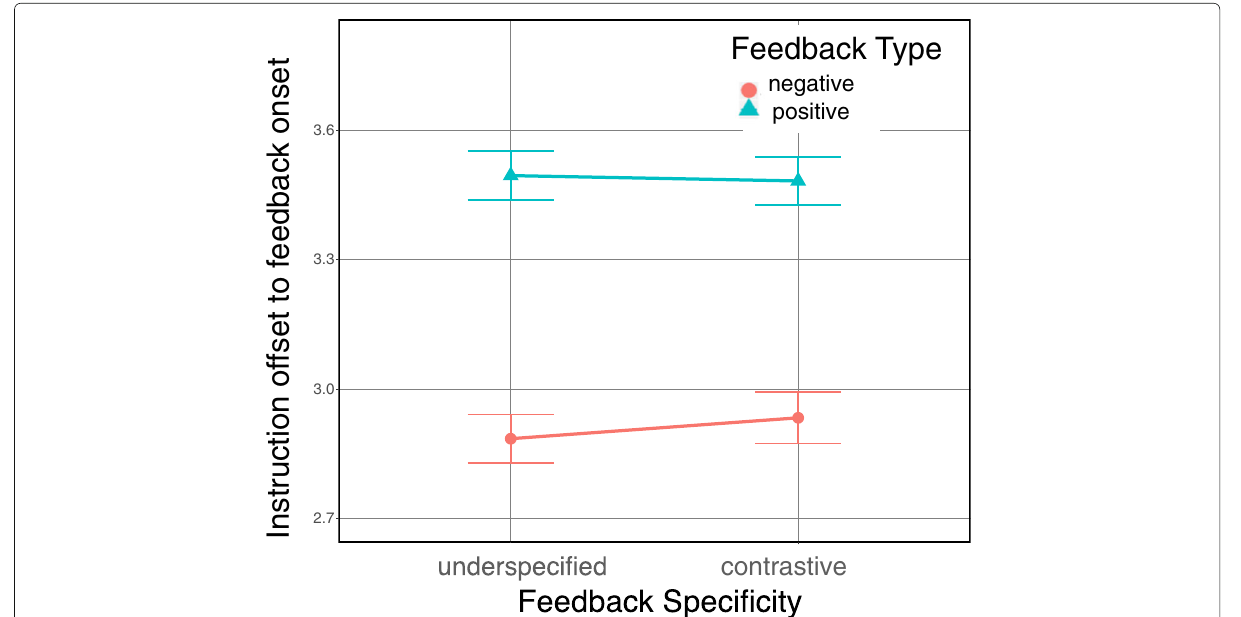
Fig. 8 Time interval from instruction offset to the onsets of the first negative and first positive feedback instances in Experiment